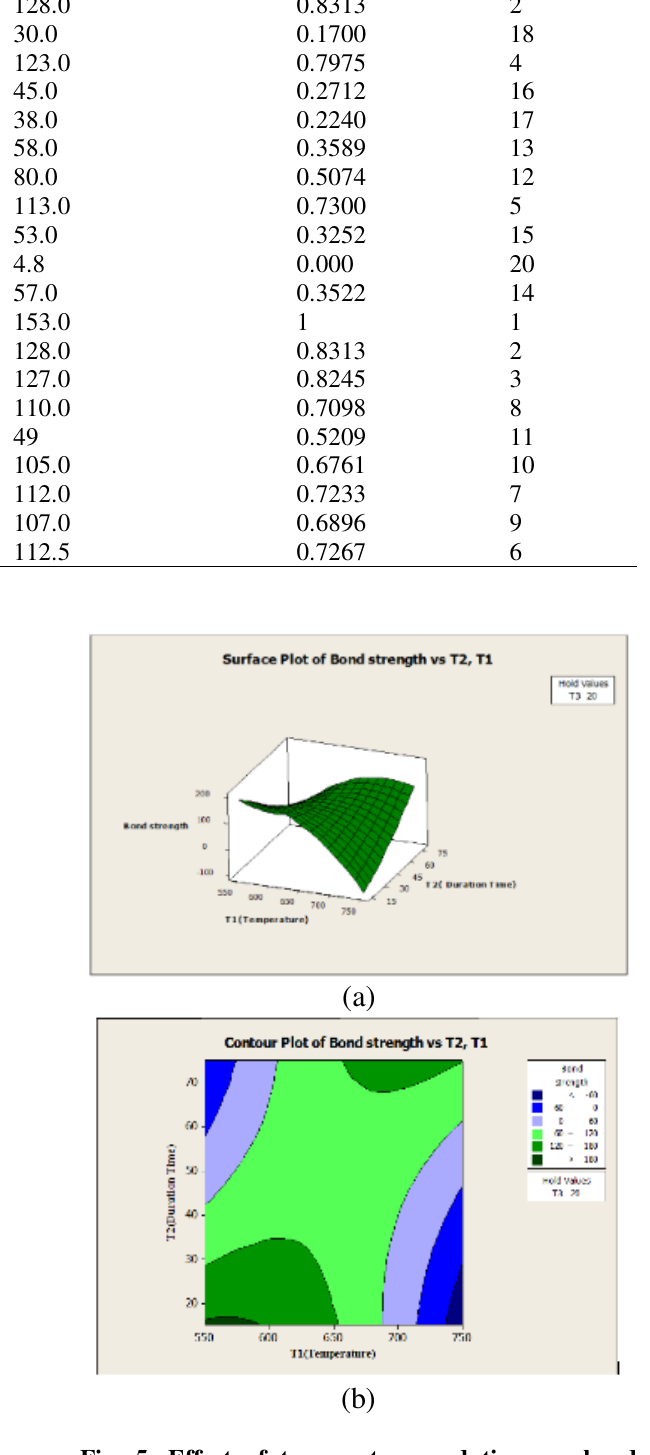
Fig. 5. Effect of temperature and time on bond strength (a) 3D surface plot (b) 2D